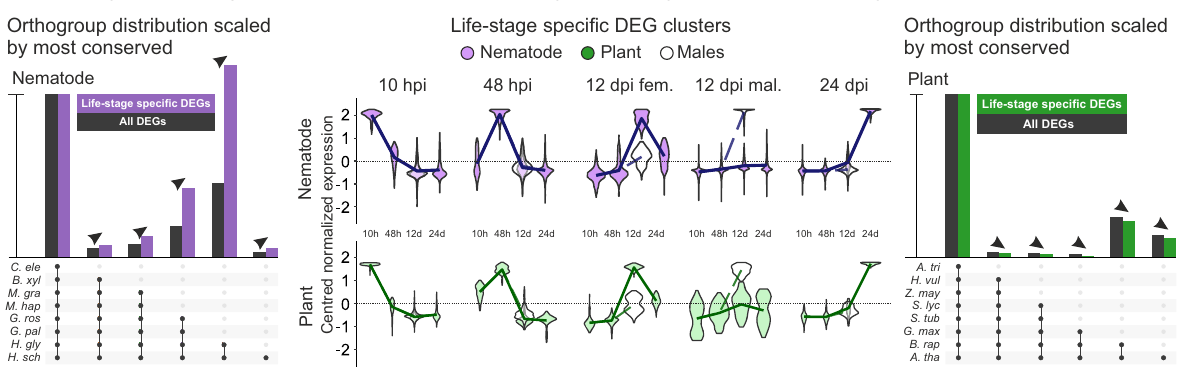
Fig. 5 | Contrasting evolutionary historiesof host and parasite genes deployed at speci fi c times of infection. Differential expression superclusters that describe discrete stages of infection (centre) for either the host (closed green) or the parasite (closed purple) where hpi=hours post infection and dpi=days post infection. Open violins represent males, or plant tissue associated with males. The orthogroup distributions (scaled to the most conserved category) are shown for eight nematode species (left - Caenorhabditis elegans, Bursaphelenchus xylophilus , Meloidogyne graminicola, M. hapla , Globodera pallida, G. rostochiensis , Heterodera